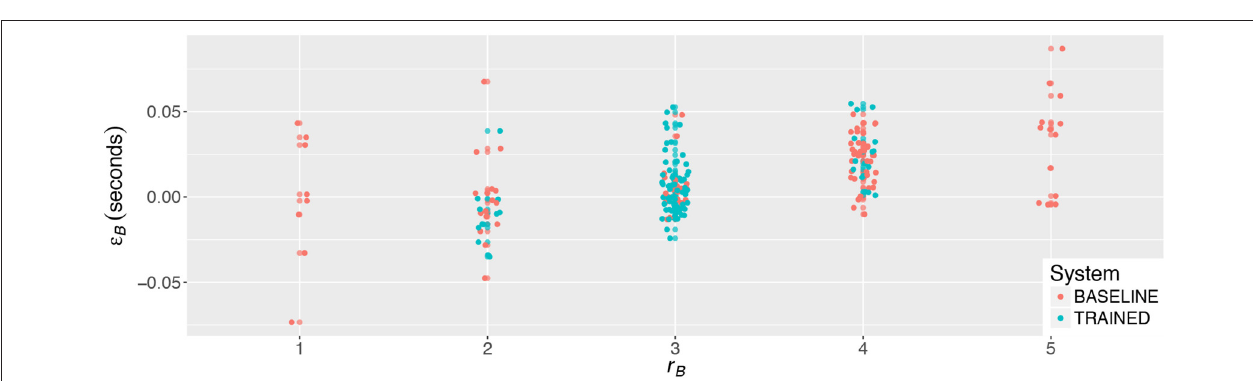
FIGURE 11 | Ratings for beat control provided by participants at the end of metronome and combined tasks.